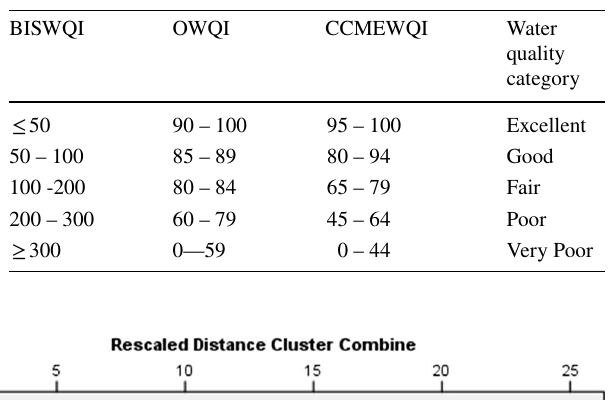
Fig. 7 Dendrogram of hierarchi- cal cluster analysis for all the stations in wet season